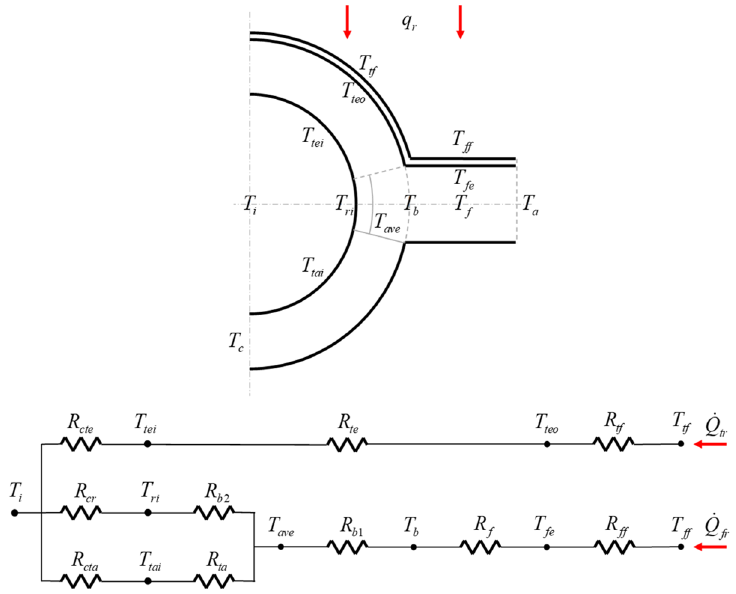
Figure 4. Equivalent thermal resistance model for the water wall taken from [27].